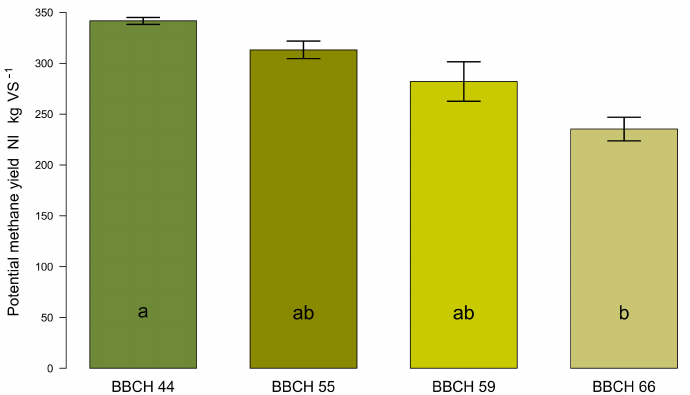
Figure 7. Potential specific methane yields (expressed as norm liters per kg volatile substrate) of common ragwort feedstock harvested at different developmental stages. Different letters inside the bars indicate statistically significant differences between the four stages ranging from BBCH 44 to BBCH 66. Error bars represent standard deviations of the